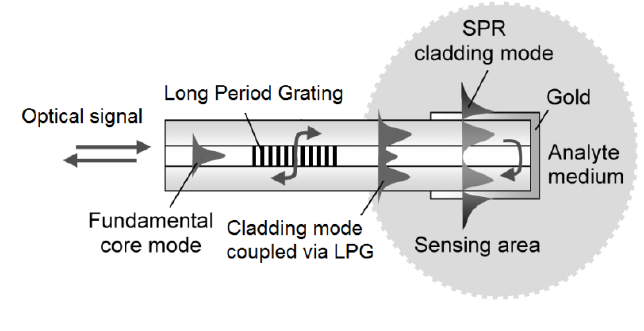
Figure 9. Set-up of the fiber-optic surface plasmon resonance (SPR) sensor proposed in [80].